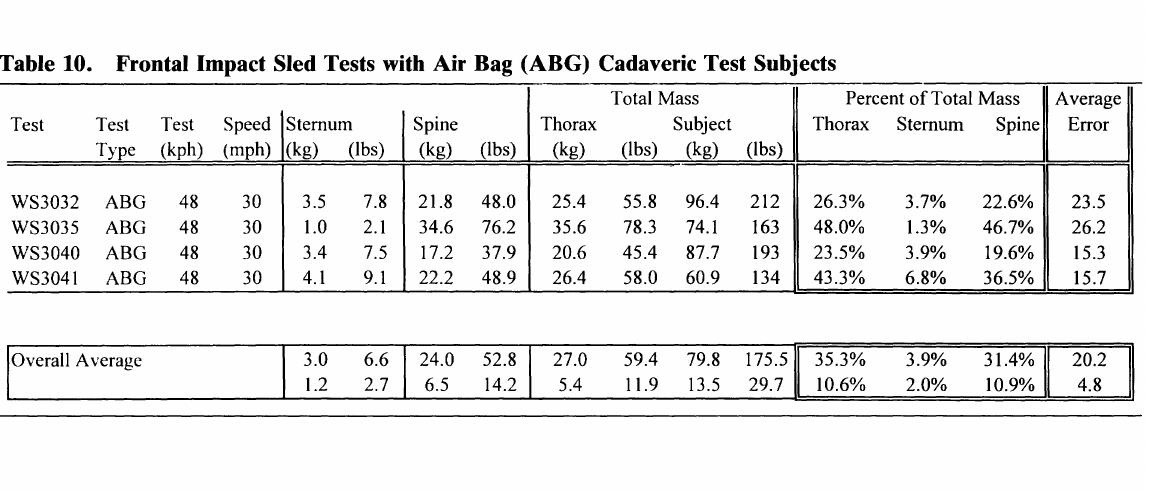
Table 10. Frontal Impact Sled Tests with Air Bag (ABG) Cadaveric Test Subjects